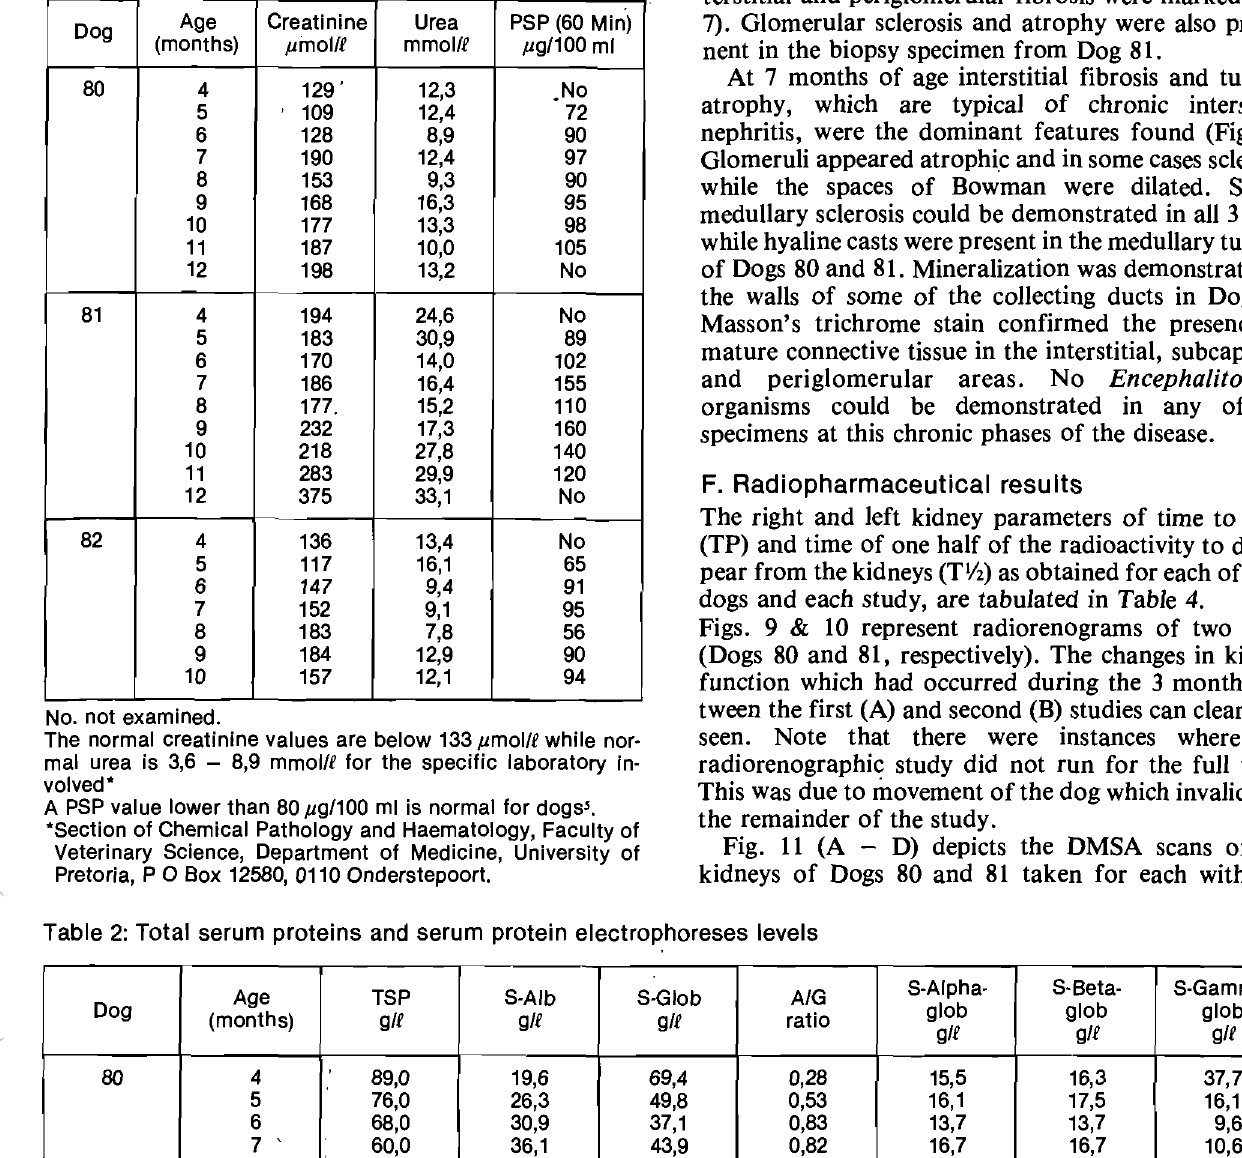
Table 1: Creatinine, urea and PSP value~ Dog